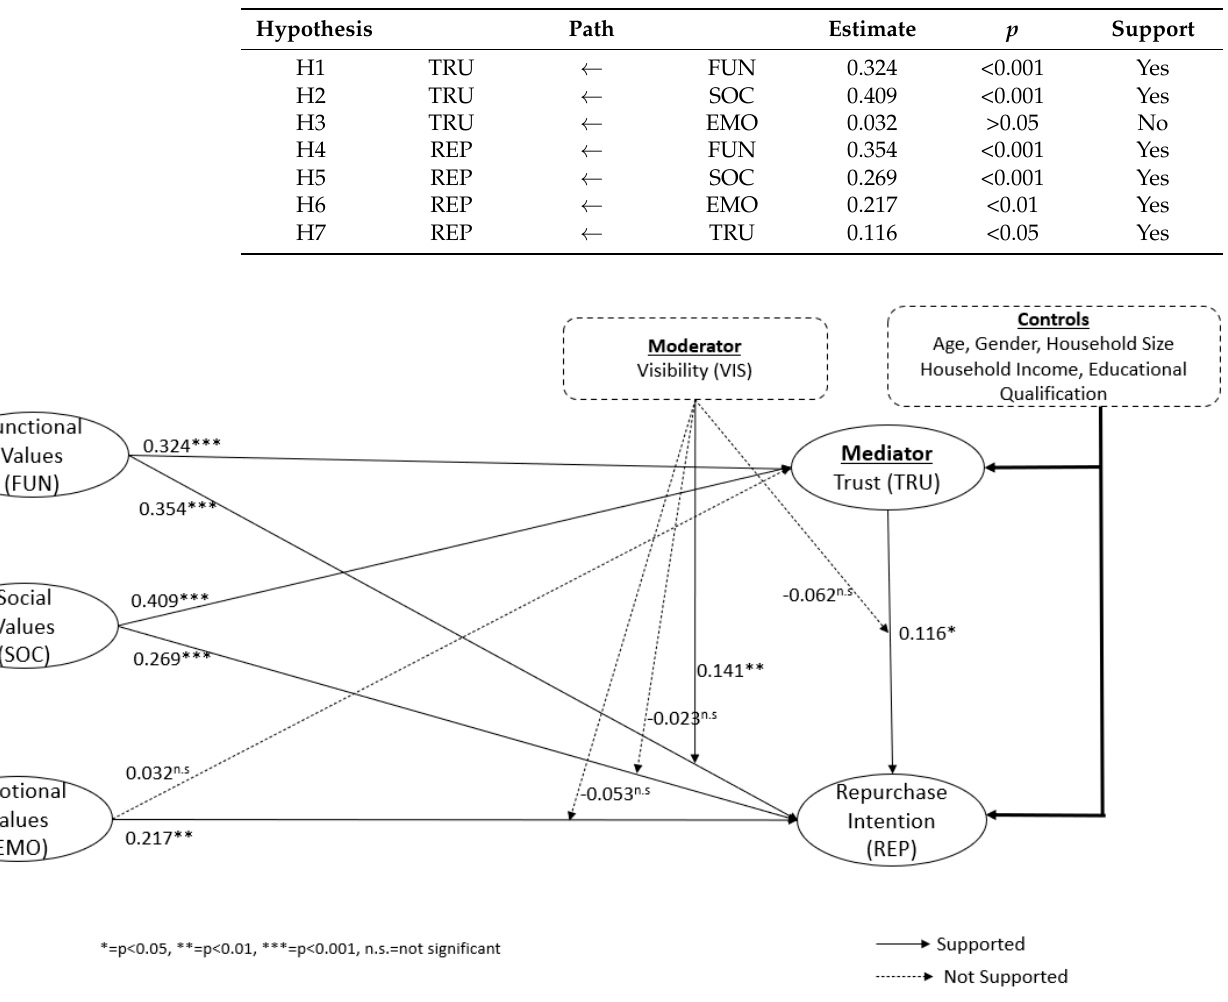
Figure 2. Results of Hypothesis Testing.